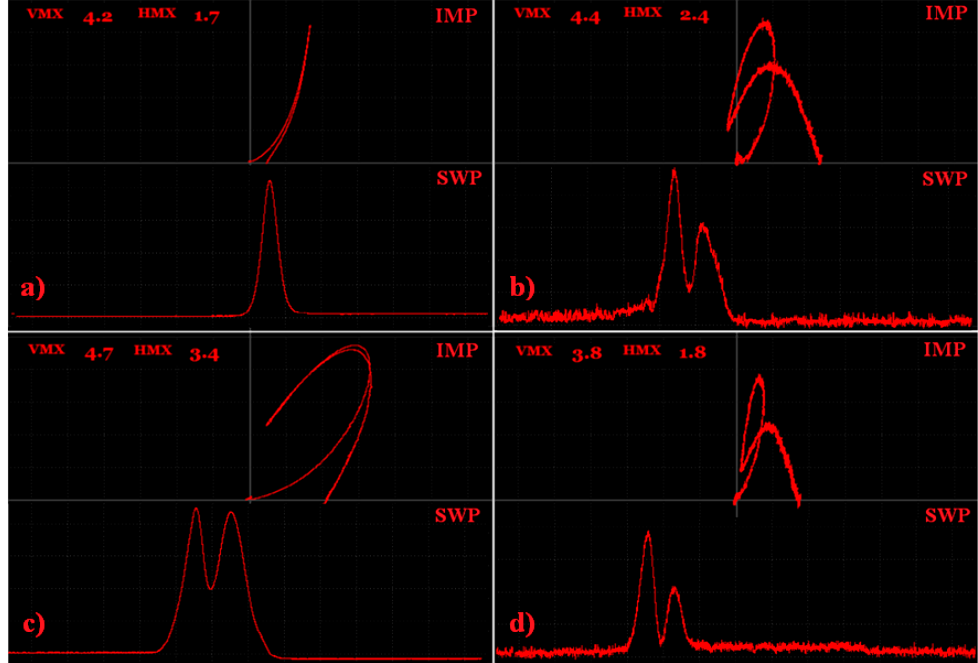
Figure 21. D6 defects signal variations; ( a ) S2 sample; ( b ) S3 sample; ( c ) S3 (reversed) sample; ( d ) S5 sample.